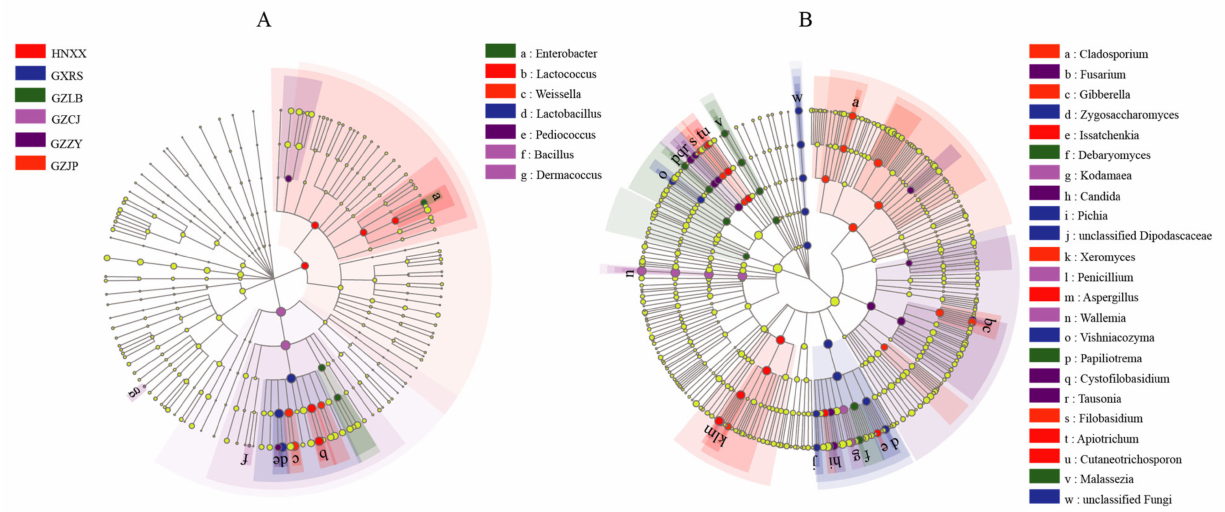
Figure 3. LEfSe analysis diagram of each dominant taxa of bacteria ( A ) and fungi ( B ) during the fermentation of SR. Nodes with different colors indicate microbial groups that are significantly enriched in the corresponding groups and have a significant impact on the differences between groups; light yellow nodes indicate that there are no significant differences in different groups ( p > 0.05). The legend on the right shows micro-organisms that have changed significantly at the genus level ( p <